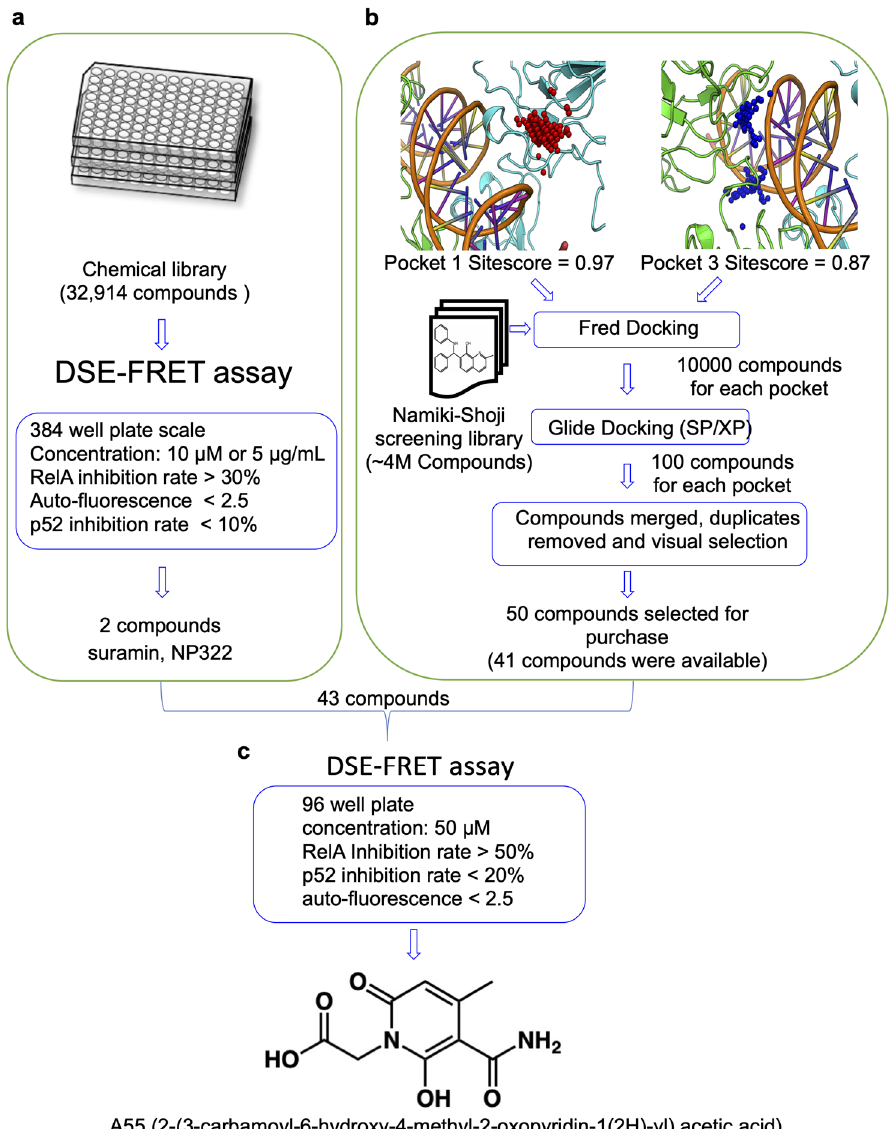
Figure 1. Screening for RelA-specific inhibitors using in silico and DNA strand exchange fluorescence resonance energy transfer (DSE-FRET) methods. ( a ) High-throughput screening (HTS) using DSE-FRET to identify selective RelA inhibitors. The inhibitory e ff ects of RelA or p52 and the autofluorescence of 32,914 compounds were evaluated by DSE-FRET at 384-well plate scale. Two compounds were finally selected as hits. ( b ) Hierarchical structure-based virtual screening to identify compounds interfering with the RelA–DNA interaction. Hierarchical molecular docking was performed separately on the predicted small-molecule binding pockets (1 and 3) on the surface of each RelA monomer. Hits from both virtual screening were merged and ~50 molecules were selected based on diversity and the interactions they make with the binding pocket. ( c ) Retest and evaluation of RelA inhibitors. The inhibitory e ff ects of RelA or p52 and the autofluorescence of suramin, NP322, and 41 available compounds at selected in silico screening were evaluated by DSE-FRET at 96-well plate scale.